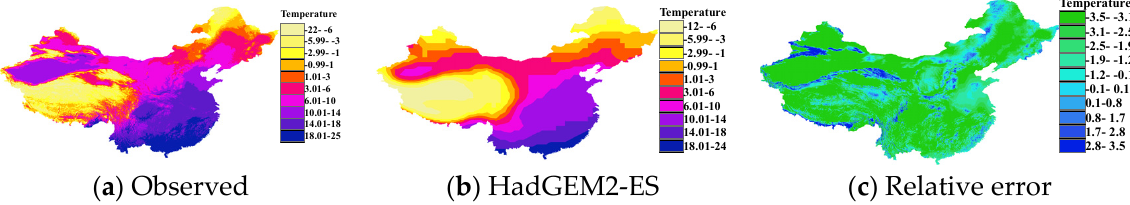
Figure 7. Spatial distribution of annual average temperature (°C) at each grid point.